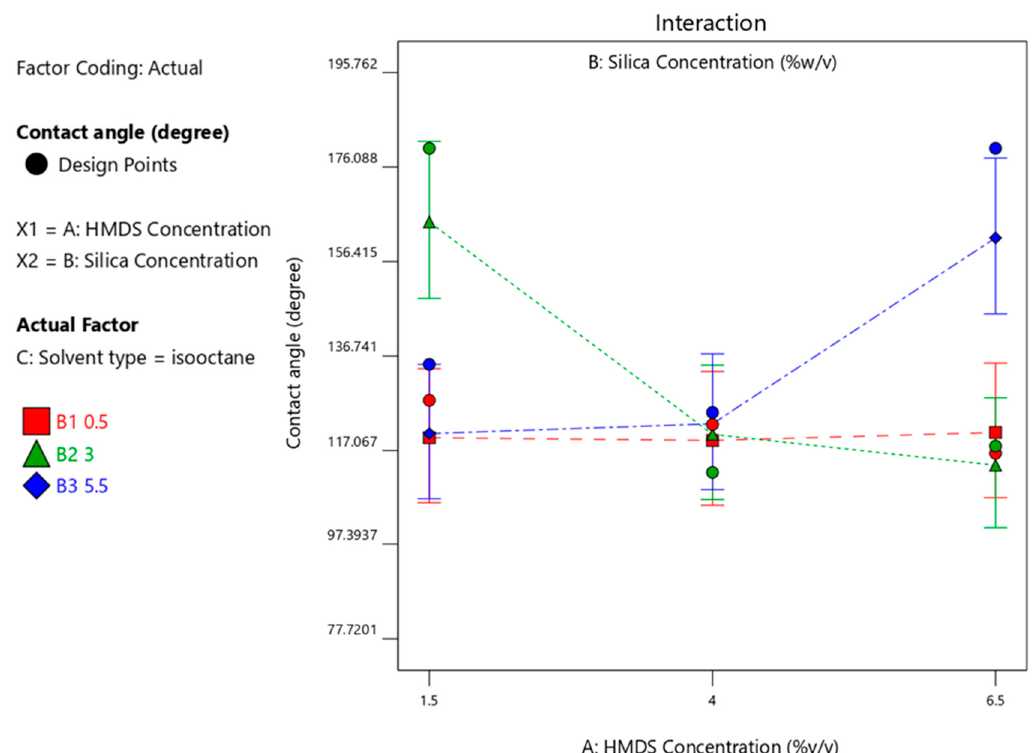
Figure 5. Contact angle response upon interaction between HMDS and silica concentration with isooctane solvent.